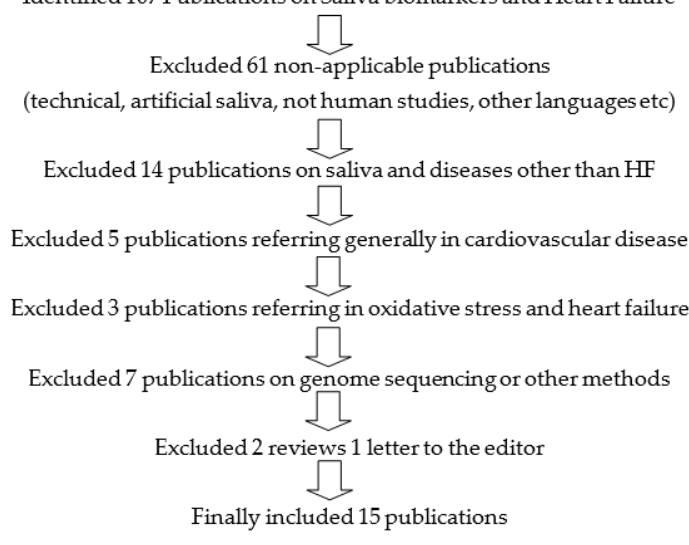
Figure 1. Search strategy on “Saliva Biomarkers and Heart Failure.